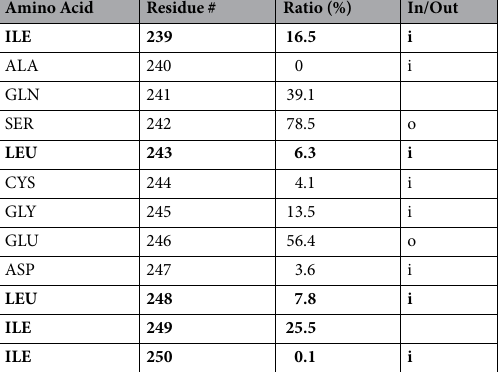
Table 1. Solvent accessibility surface of residues within TDP-43 putative NES. Using the NMR data from Lukavsky et al . 20 and an algorithm developed by Braun et al . 44 , the solvent accessibility of the putative NES was calculate (hydrophobic residues bolded). The first two columns are the amino acid identity and residue number. The third is the side chain surface area, normalized to a “random coil” of that residue. Resides are classified as solvent exposed if this normalized value exceeds 50% (labelled “o”) and buried if the normalized value is less than 20% (labelled